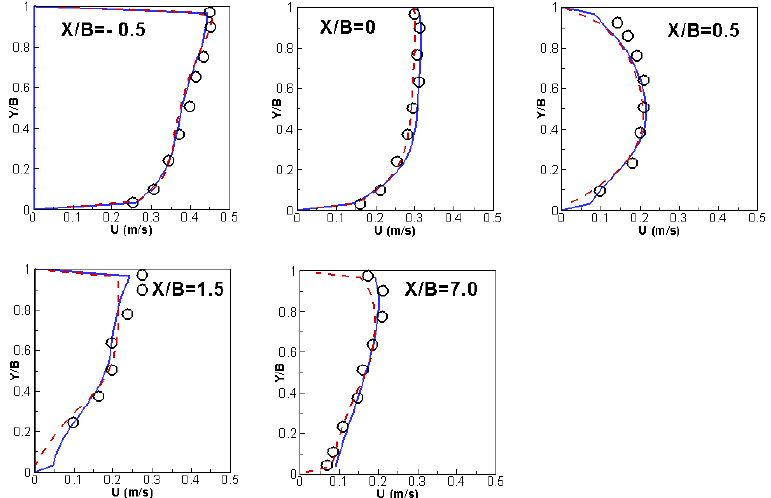
Figure 3. Comparison of x-velocity profiles at selected x locations in the main channel (Solid Blue Line: SRH-3D; Red Dashed Line: SRH-2D; Symbol: Experiment).